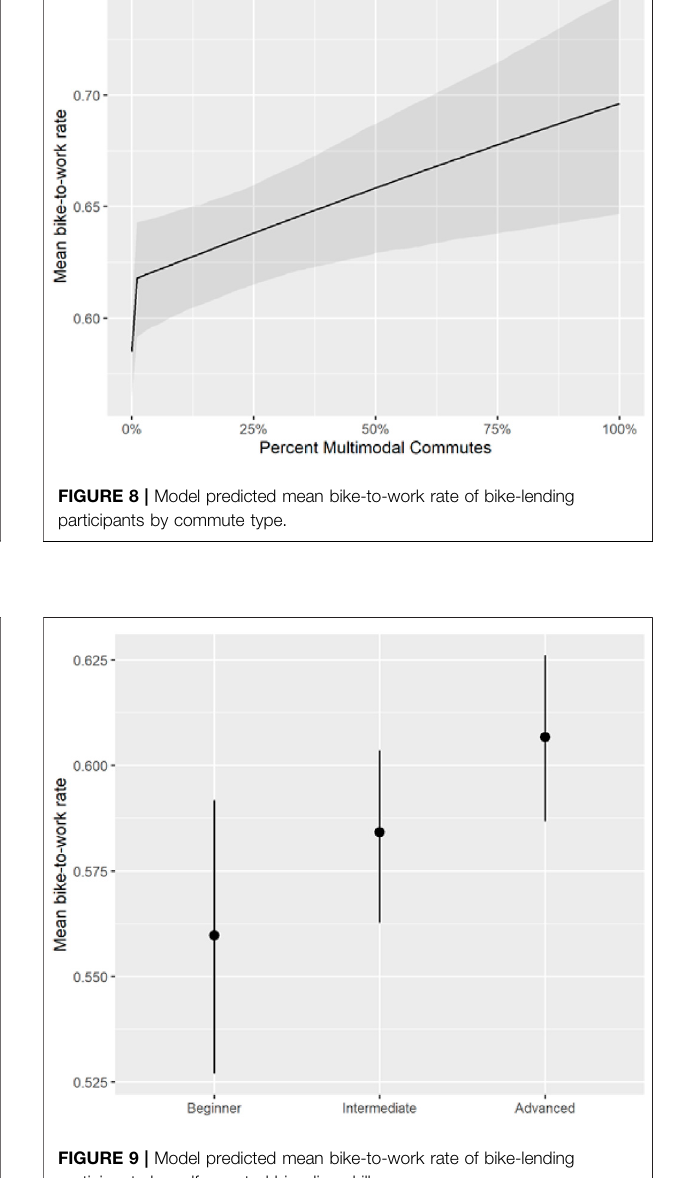
FIGURE 9 | Model predicted mean bike-to-work rate of bike-lending participants by self-reported bicycling